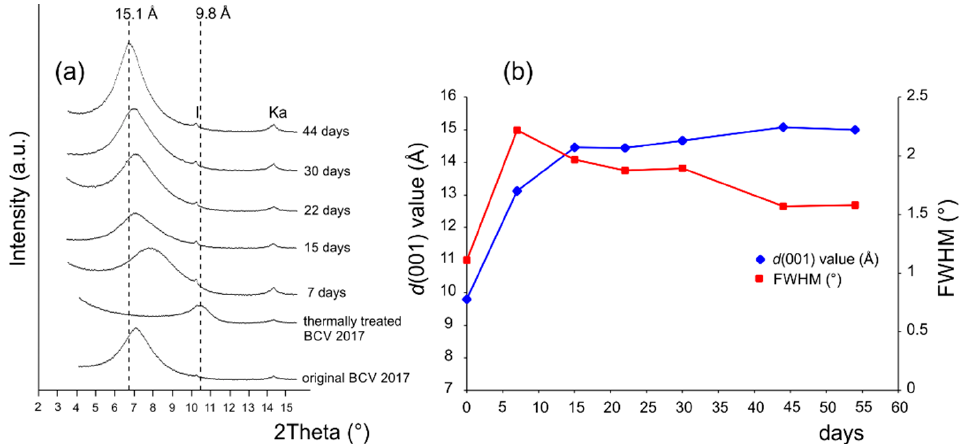
Figure 7. Evolution of ( a ) the PXRD profile, ( b ) the d and FWHM of the 001 montmorillonite reflection for the thermally treated BCV 2017 sample during saturation from the aqueous phase (CoK α radiation). The days indicate the duration of saturation. I: illite, Ka: kaolinite.